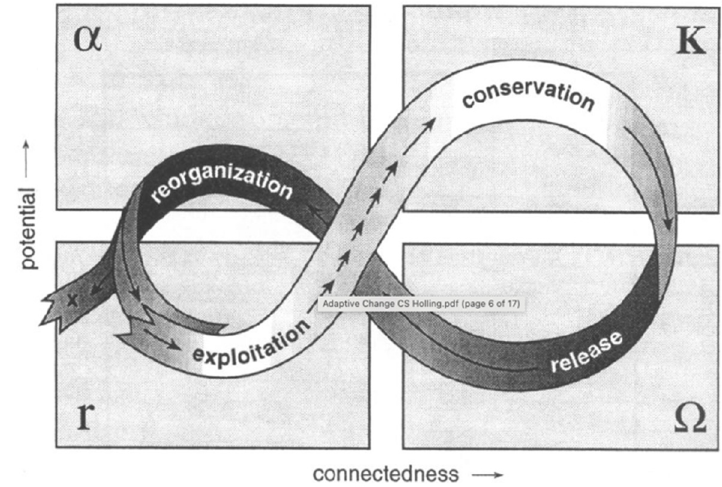
Figure 1. Stylized representation of Holling’s Adaptive Cycle for ecological, economic, social, and cultural change. Four distinct sectors ( α , r, K, and Ω ) represent phases of greater and lesser stability and disruption, with corresponding variations in connectedness and potential: the more connectedness a system builds during periods of heightened implementation (r) and codification of efficient functionality ( Κ ), the greater the potential for disruptions, or crises ( Ω ), to build new forms and levels of resilience during periods of reorganization ( α ).